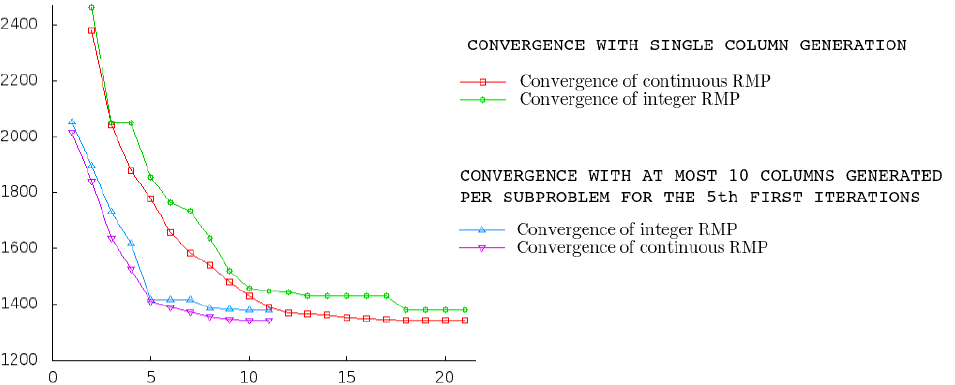
Figure 1. Illustration of the CG convergence of RMP and integer RMP for an instance with 40 jobs and 15 technicians with 20 different